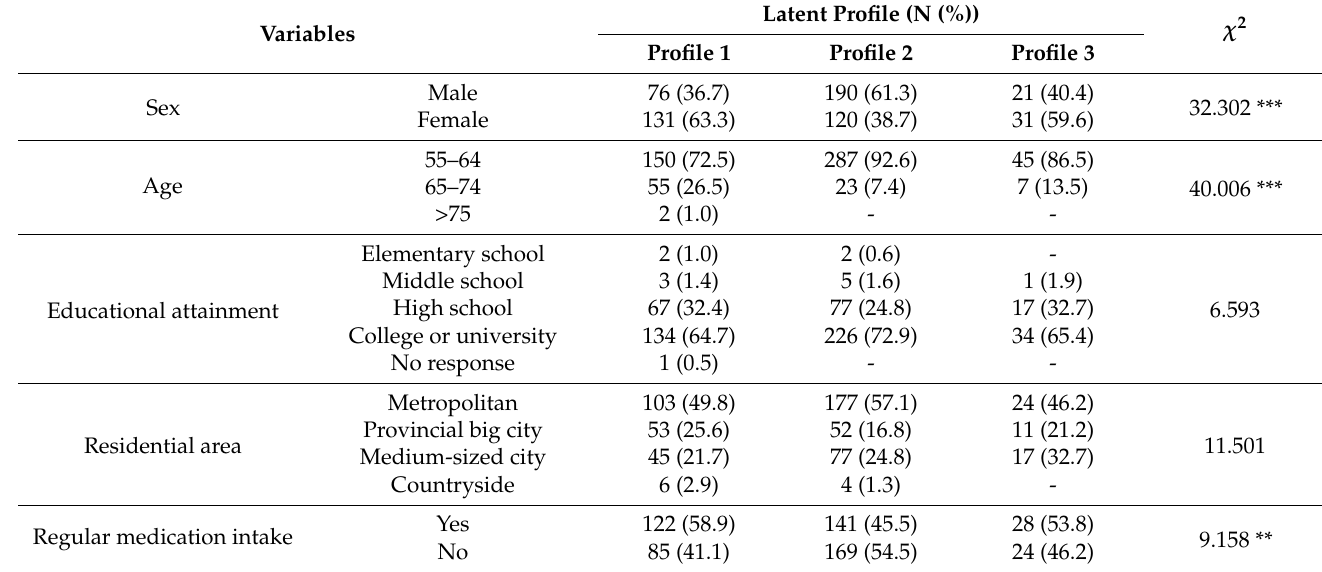
Table 3. Demographic characteristics of identified three different lifestyle profiles.